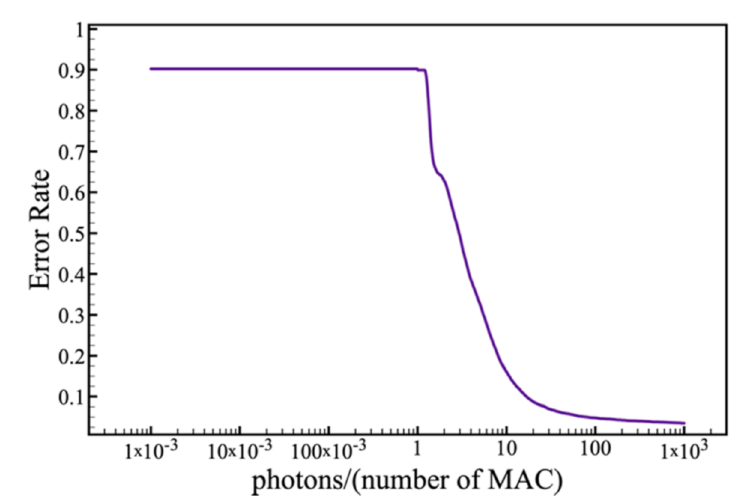
Figure 4. Error rate vs. photon / n MAC